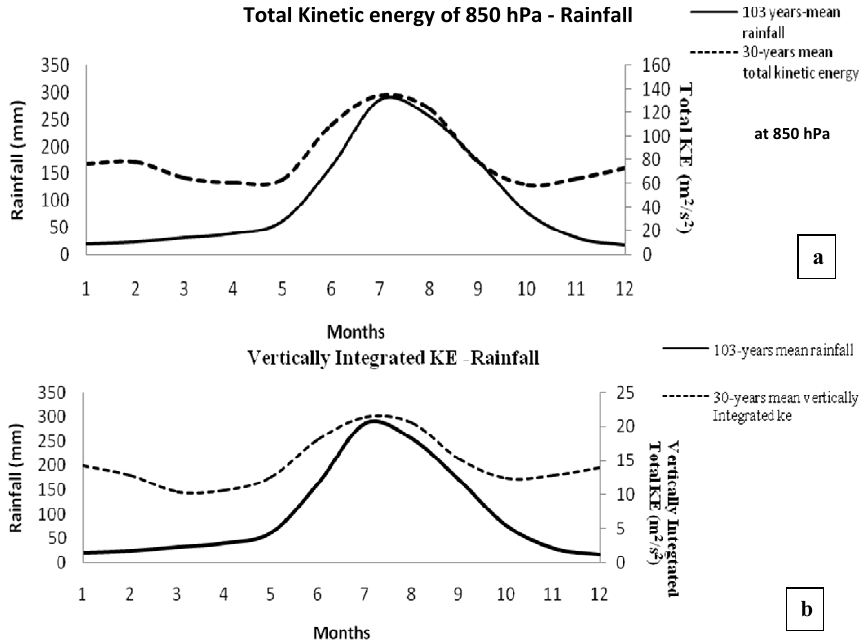
b Fig. 4. Time series of monthly rainfall (103 years mean 1901–2003) for 12 months compared with the total kinetic energy at 850hPa (30 years mean 1980–2009) and vertically integrated (1000–100hPa) total kinetic energy (30 years mean 1980–2009).